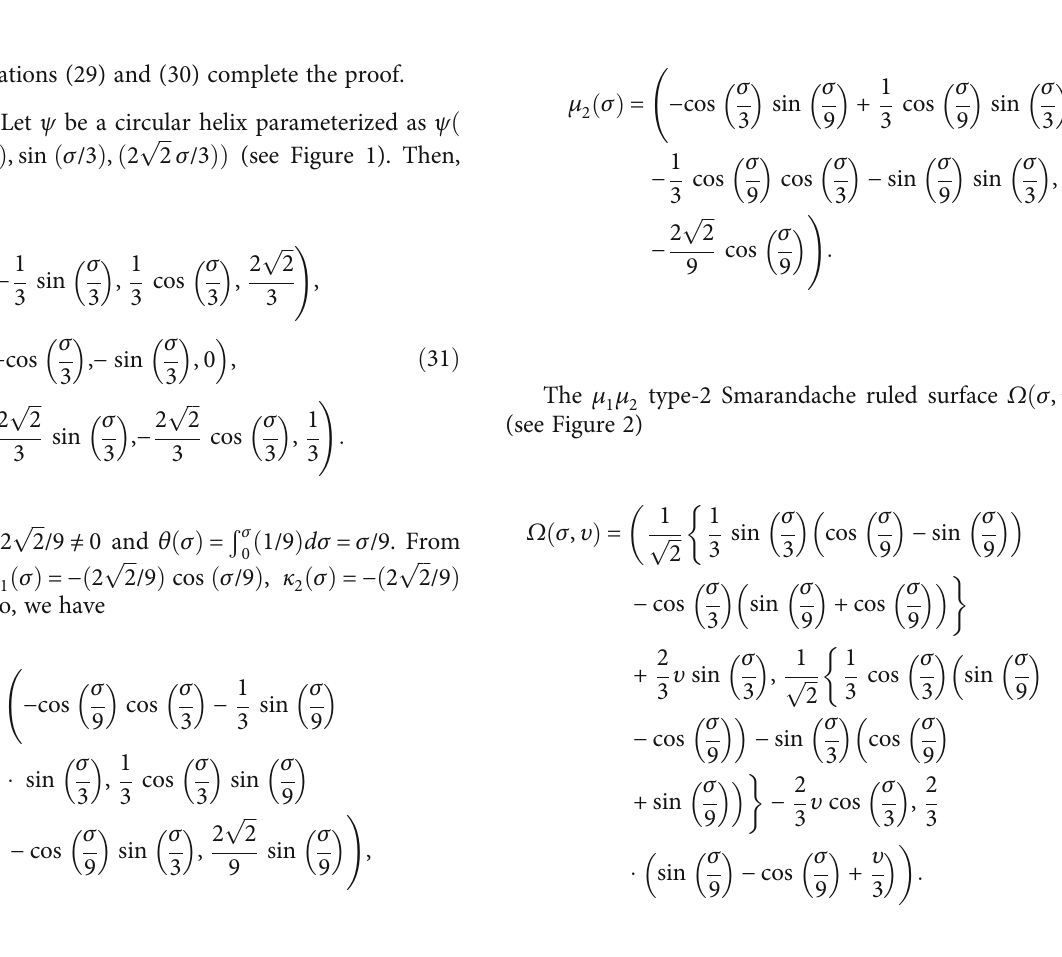
Figure 1: Curve ψ = ψ ð σ Þ